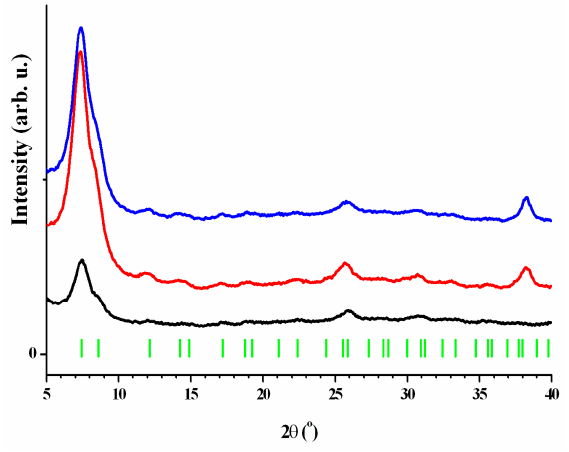
Figure 9. XRD patterns of the meso-NH 2 -UiO-66 (black), 5%Au@meso-NH 2 -UiO-66-before-catalysis (red) and Au@meso-NH 2 -UiO-66-after-catalysis (blue) samples. The vertical bars denote calculated positions of the peaks for the cubic crystal structure UiO-66.